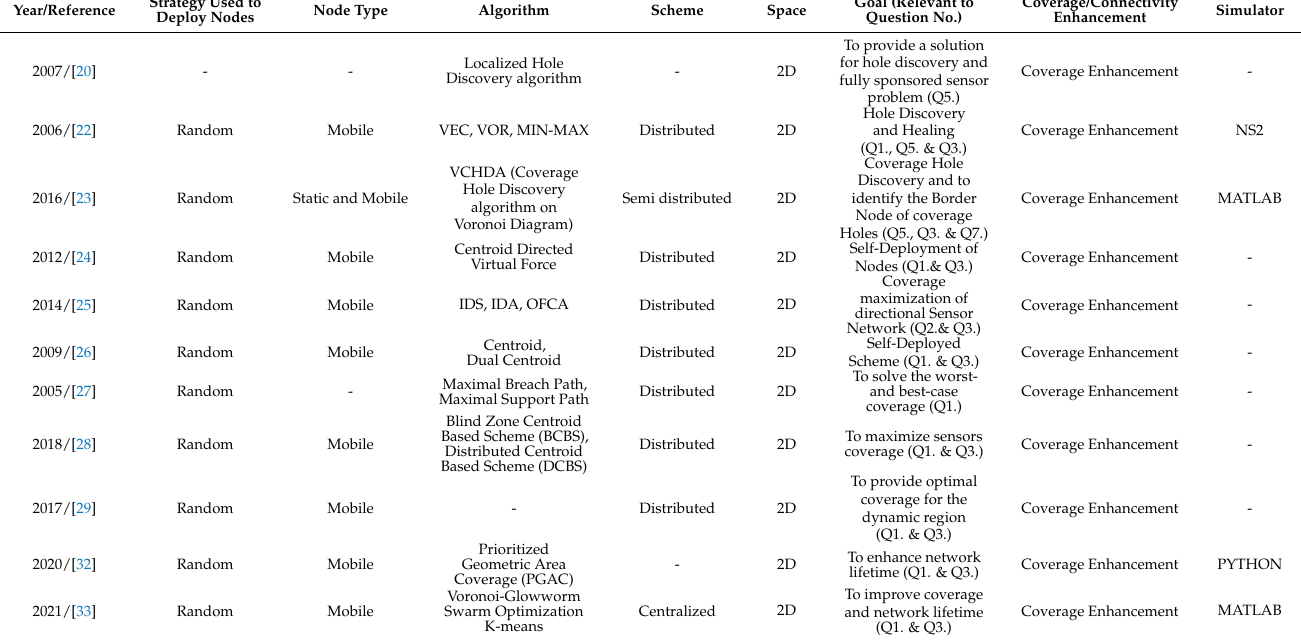
Table 2. An Overview of the Different Voronoi Diagram-Based Techniques to Improve Coverage and Connectivity in